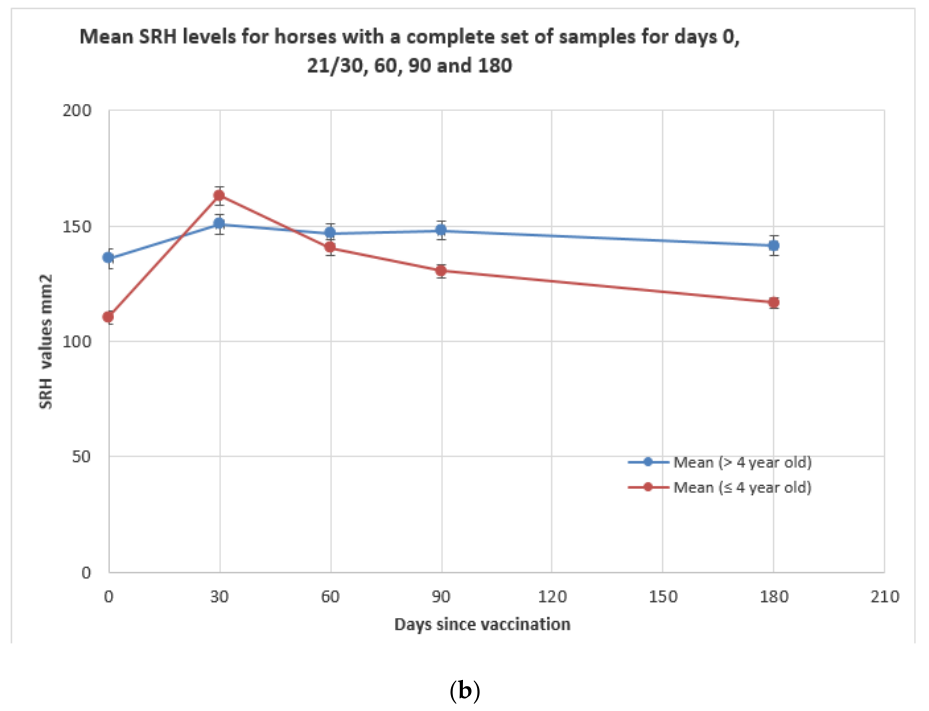
Figure 5. ( a ) The decline in SRH antibody level ≥25 mm 2 experienced by horses four years old or younger and those over four years old between days 21/30 and 60, days 60 and 90, and days 90 and 180 post-booster vaccination. ( b ) The mean SRH antibody levels for 150 horses (four years old or younger (red), n = 96; over four years old (blue), n = 54) with a complete set of samples for days 0, 21 (German horses only) or 30 (this sampling is represented on the horizontal axis of the graph as Day 30), 60, 90, and 180.